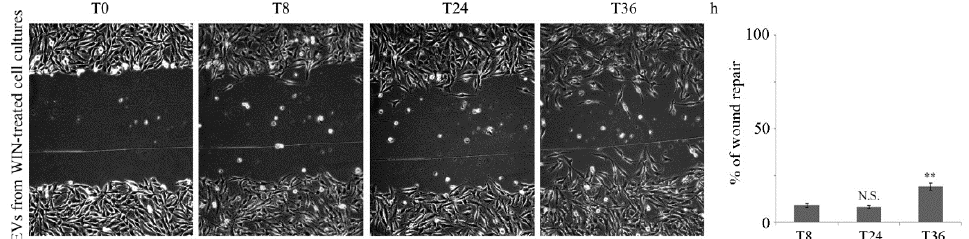
Figure 6. Extracellular vesicles from WIN-treated cultures halt MG63 cell migration. Wound healing migration assay of MG63 cells in the presence of EVs (50 µg/mL) isolated from WIN-treated cells. The average distances between cells at the edges of the gaps in the wound healing assay were estimated through ImageJ software. Pictures reported were taken at different time points after wounding (magnification 200×). On the right of the picture a graph of the mean percentage area healed at T8, T24 and T36 post-wounding is shown. (**) p < 0.01 compared to the original gap at T0. N.S. not significant.